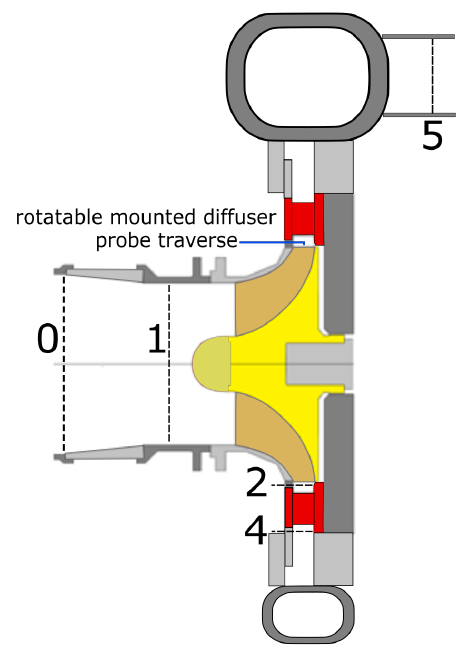
Figure 3. Scheme of testing section of